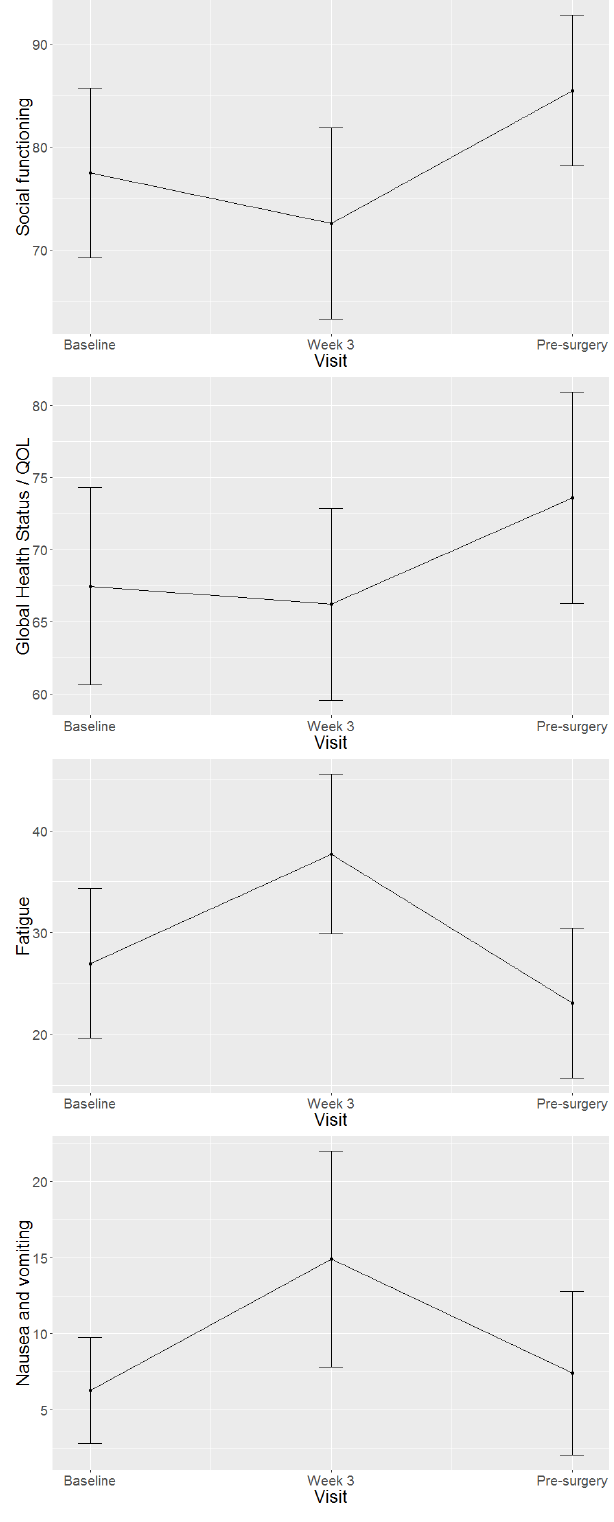
Figure 1. Figure 1. Cont.